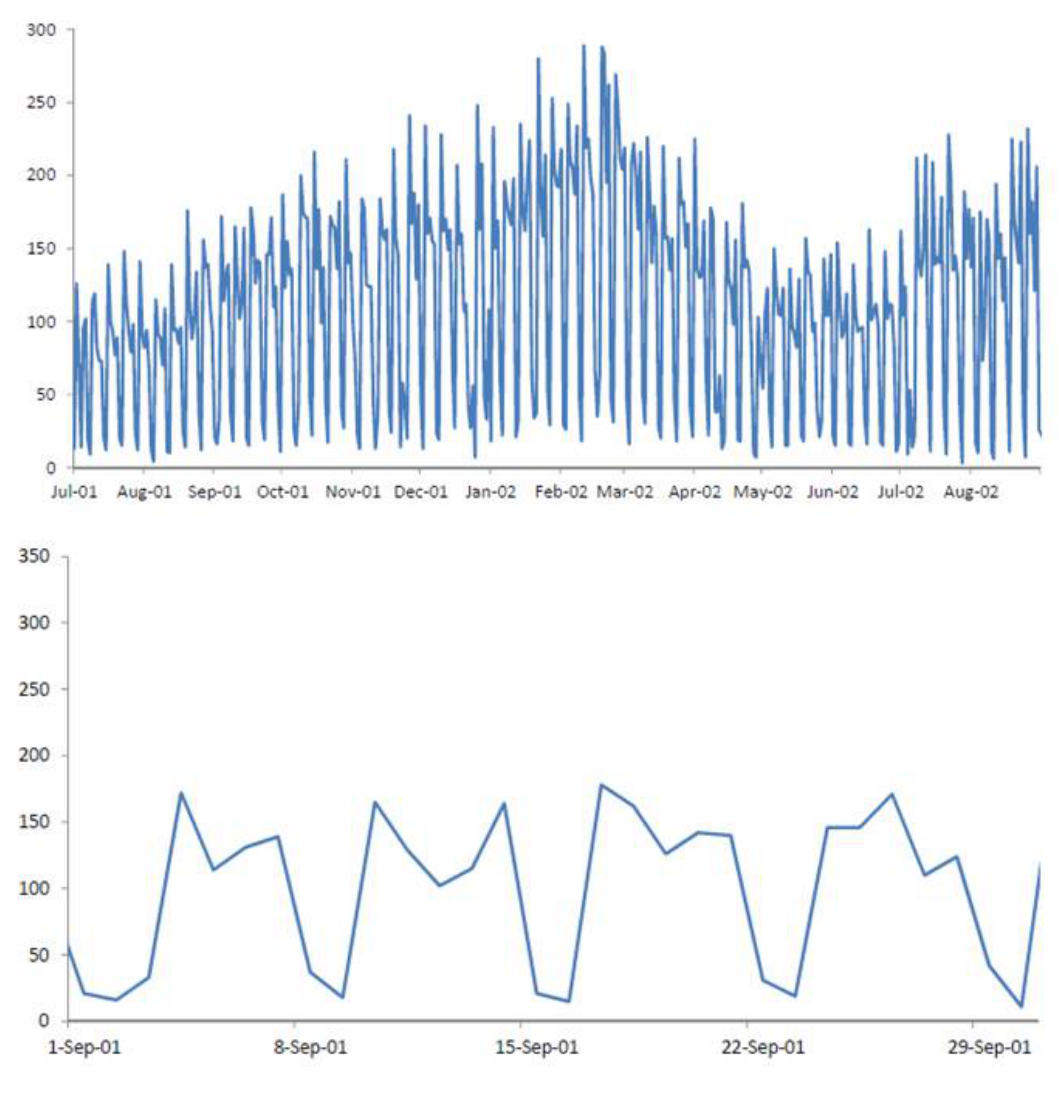
Figure 1. Daily number of respiratory chief complaints among visits to military outpatient clinics in Charleston between July 2001 and August 2002 (top) and zoomed-in view during September 2001